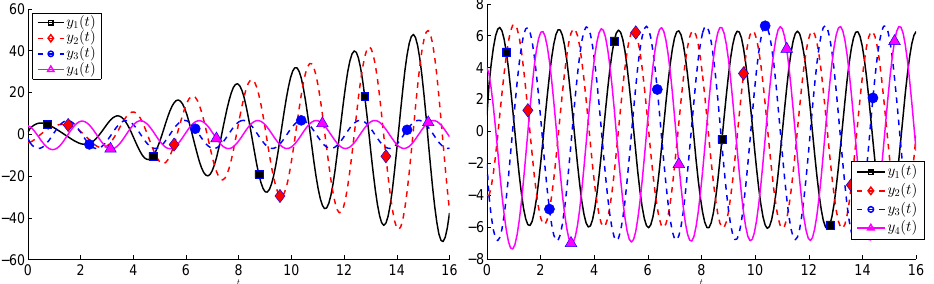
= Ay ( t ) , with q = 2/3, for A = A 0